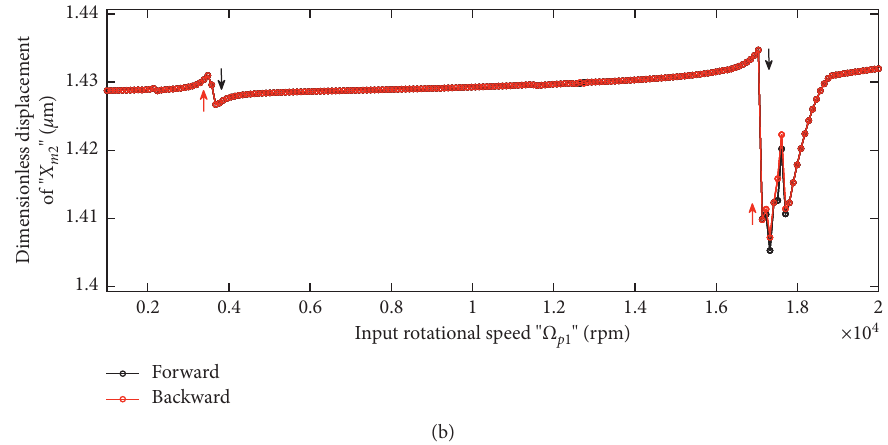
Figure 10: RMS curves of forward and backward behaviors of system at s